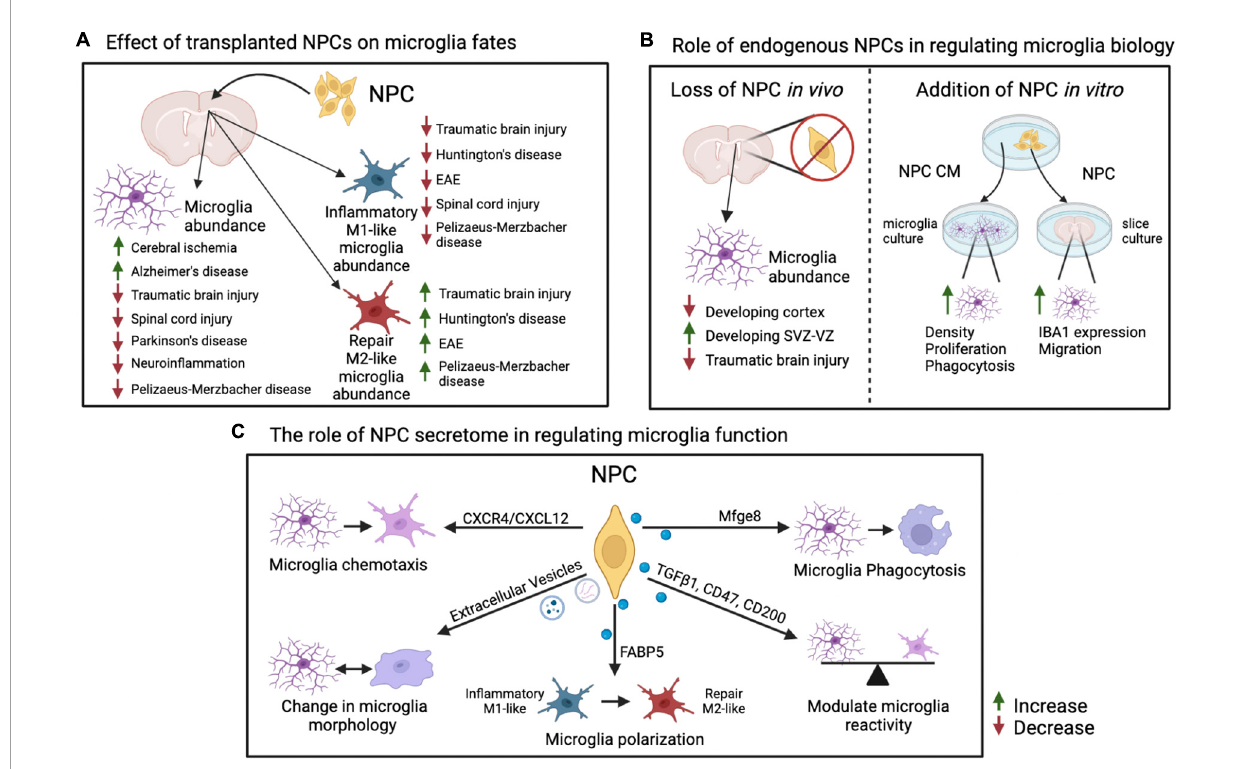
FIGURE1 Summary of effects of NPCs on microglia fates. (A) Effects of transplantation of exogenous NPCs on microglial abundance and reactive states in various inflammation and disease models. Increase in total or M1-like/M2-like microglia abundance within a model is indicated with an upward green arrow, decrease is indicated with a downward red arrow. (B) Endogenous role of NPCs on microglia activity and localization via ablation of NPCs in vivo or addition of NPCs in vitro . (C) Factors and pathways originating in NPCs that have specific effects on microglial reactivity and functions. Please see text for details and references. This figure was generated using BioRender and Adobe Illustrator. NPC, neural precursor cell; EAE, experimental autoimmune encephalomyelitis; CM, conditioned media; SVZ, subventricular zone; VZ, ventricular